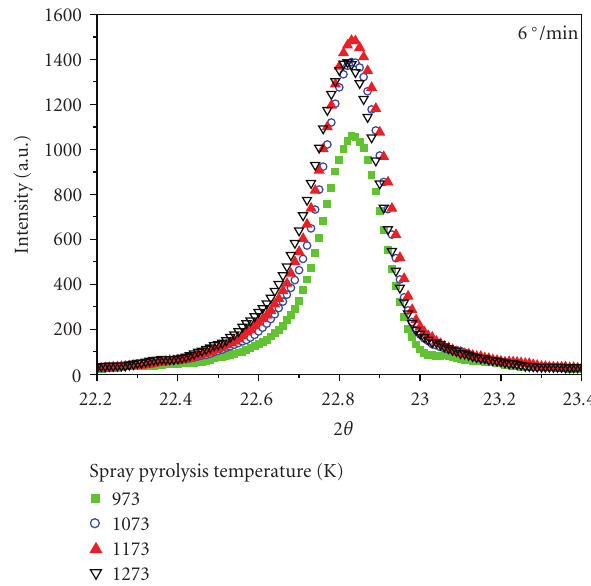
Figure 7: XRD patterns of the peak at 2 θ = 22 . 8 ◦ for NaTaO 3 powder synthesized at several spray pyrolysis temperatures.